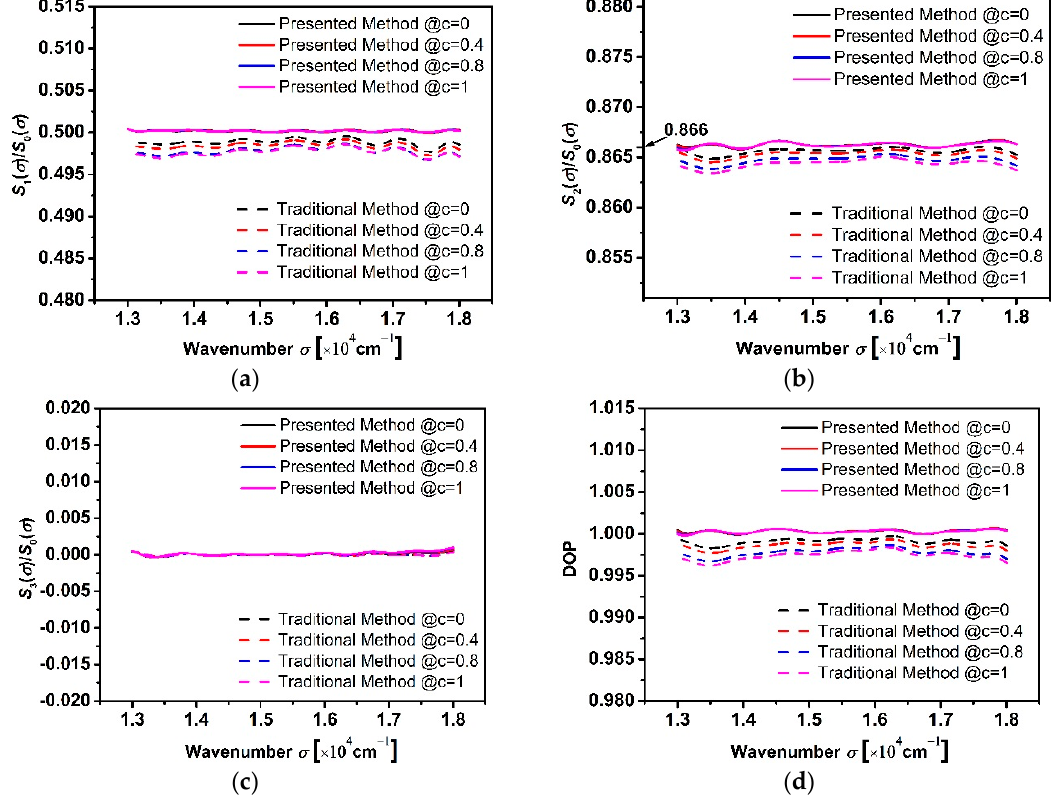
Figure 9. Reconstructed results of normalized Stokes parameters and DOP, wherein the solid and broken line respectively represent the presented calibration method and the traditional calibration method, and the different colors represent reconstruction results at different field of view. ( a ) S 1 / S 0 ; ( b ) S 2 / S 0 ; ( c ) S 3 / S 0 ; and ( d ) DOP.